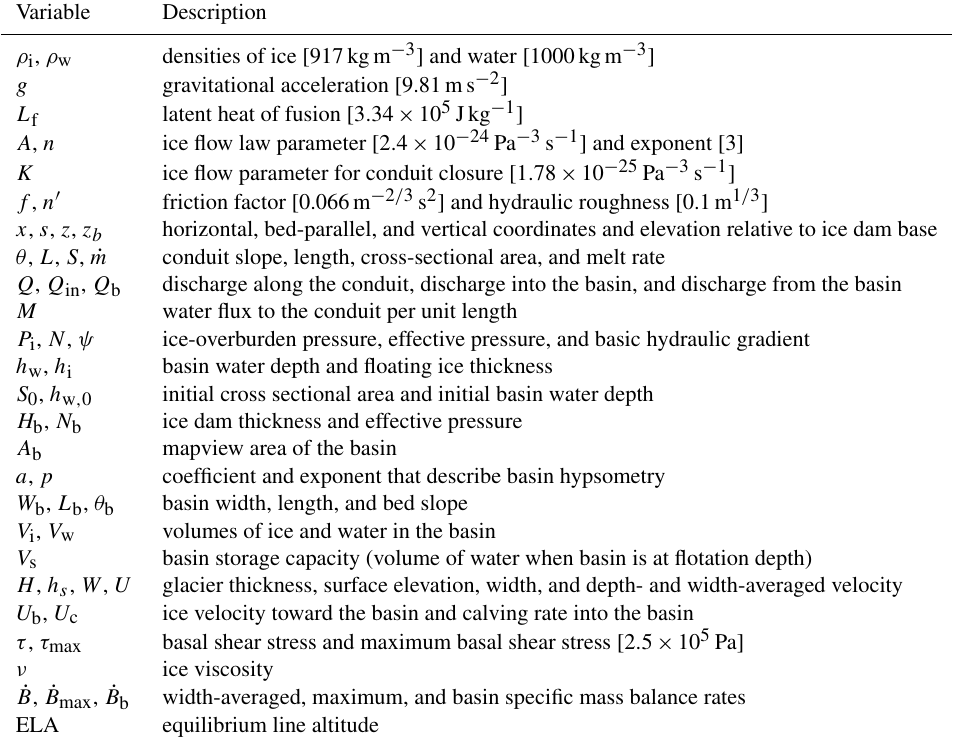
Table 1. List of model parameters. Values of constants are specified in brackets.